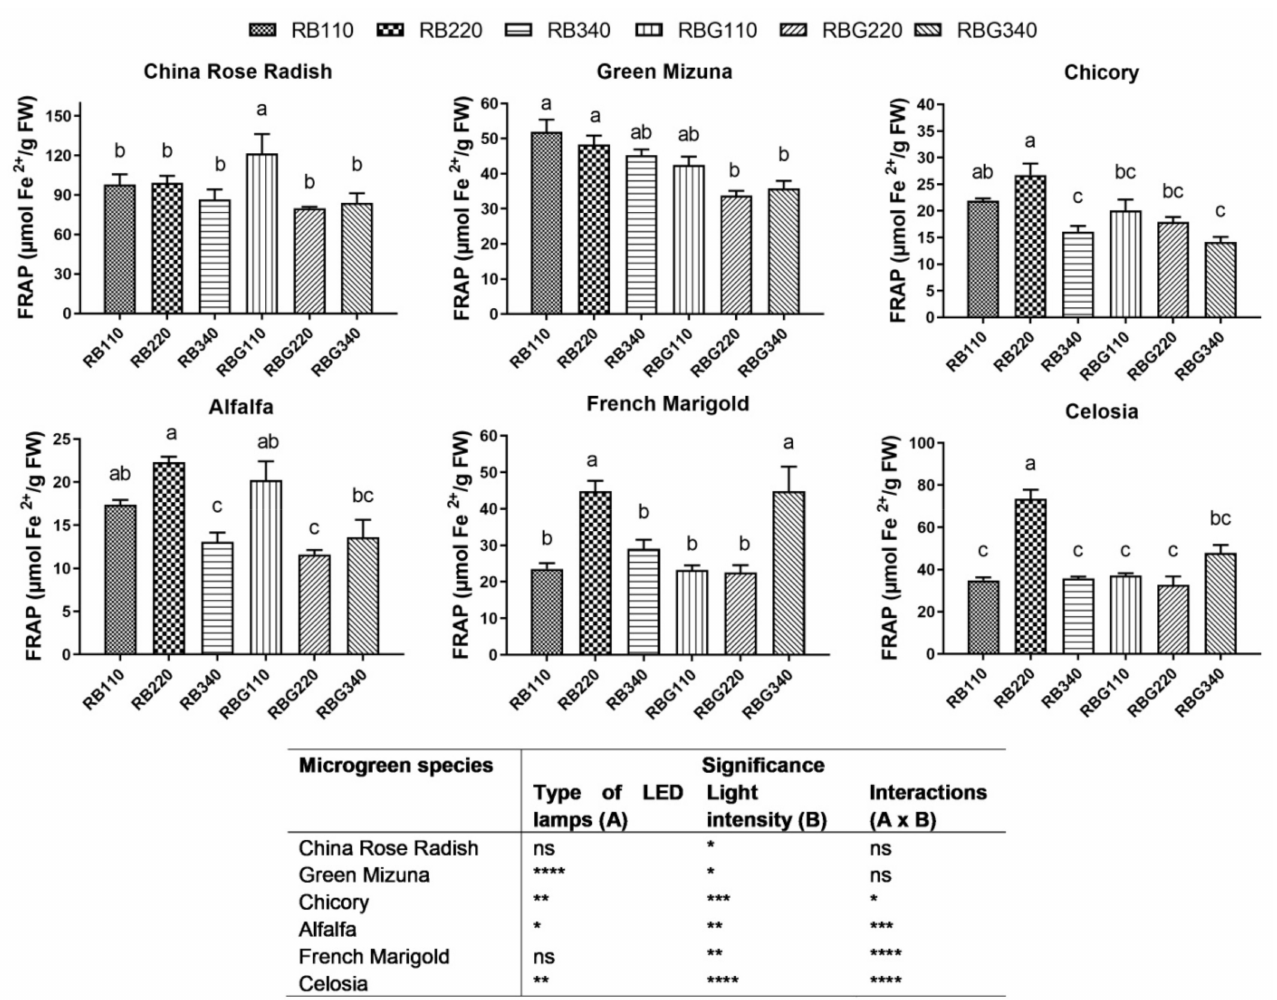
Figure 3. Reducing capacity of extracts from six microgreen species affected by different light environments determined by FRAP test. Data are shown as means with at least five independent biological replicates and error bars indicate standard error (SE). Data were subjected to two-way analysis of variance and differences were analyzed by Tukey’s post-hoc. Different letters denote significant differences at p < 0.05. Levels of significance of the parameters assessed for each microgreen species considered where: ns, *, **, ***, ****, are not significant, significance at p < 0.05, 0.01, 0.001, and 0.0001 respectively. When there was not significant A × B interaction, the effect of light spectra (A) and light intensity (B) was evaluated separately using one-way ANOVA and t -test, respectively (Supplementary Table S1). Different letters on the histograms within each light spectrum (RB and RGB) indicate significant differences among light intensity (Tukey’s test, p <